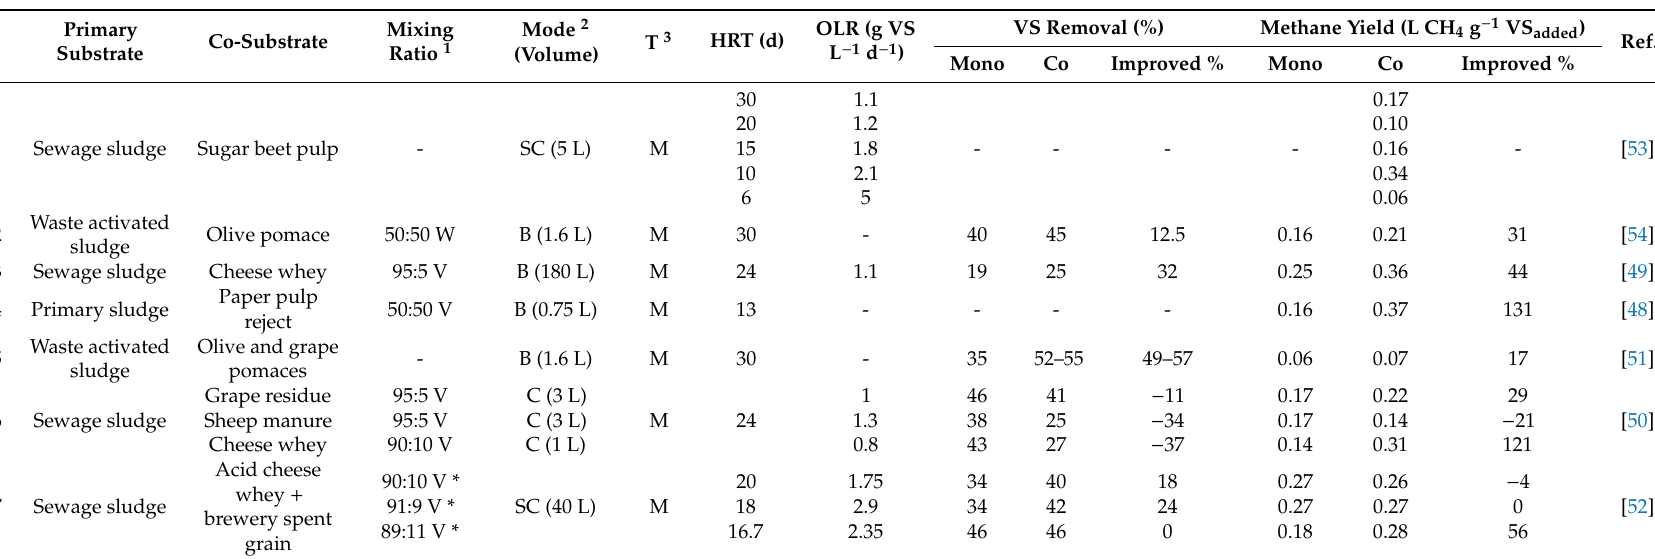
Table 4. Summary of studies using agricultural wastes as co-substrate in anaerobic co-digestion of wastewater